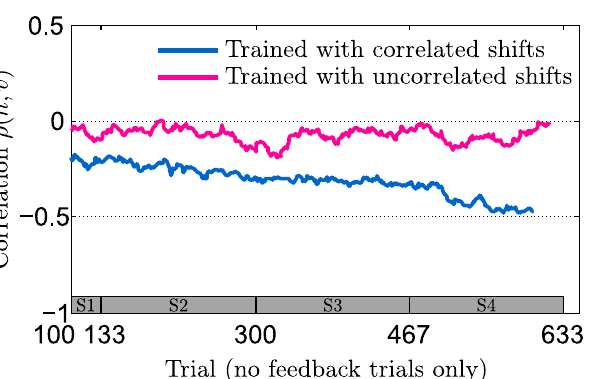
Fig 11. Simulation results. Median for evolution of xy-correlation in no feedback trials — compare Fig 8A and 8B which shows the participants ’ results. The plot shows the simulation results as medians over six different simulation runs. The blue line shows the median over six runs where the model was trained with correlated full feedback trials. The pink line shows the median over six runs where the model was trained with uncorrelated full feedback trials. The parameters of the model (strength of the initial belief over mean-shift and covariance matrix) were chosen in order to minimize the sum-of-squared-differences between the correlated simulation median and the median obtained from participants from the correlated group. The uncorrelated simulation run used the same set of parameters.